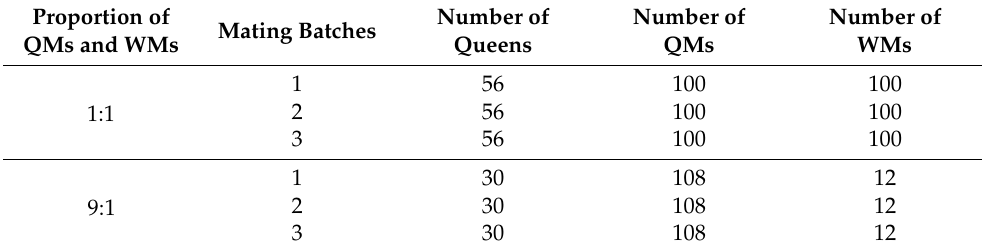
Table 1. The number of individuals in competitive